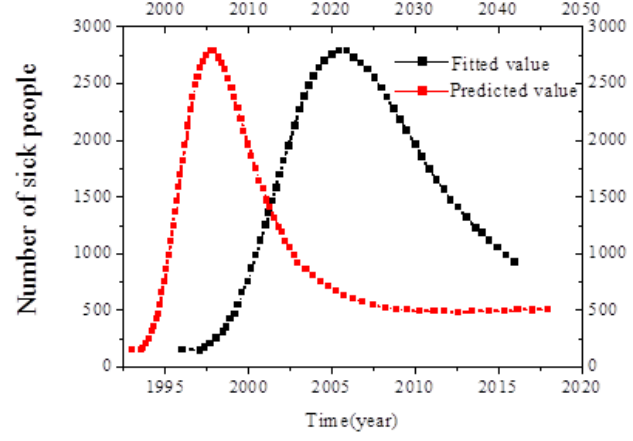
Figure 2. Fitting and prediction data of the number of infected